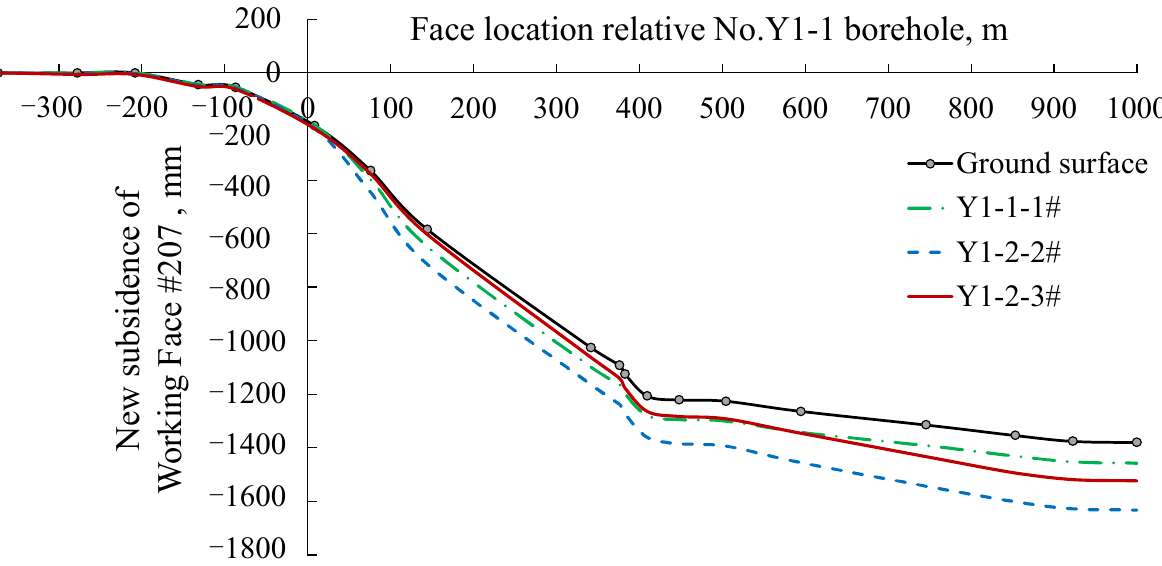
Figure 15. New subsidence caused by the mining of Working Face #207. By performing a borehole-based in situ survey of strata fractures, comparing the distribution of cracks in the UTHS before and after the mining of Working Face #207, and monitoring both the internal strata movement and surface displacements of this region, we determined that the Luohe Formation UTHS was not poised in a suspended and unmoving state during the mining of Working Face #207. Therefore, it was unlikely that a large and sudden break would occur in the UTHS during the mining of Working Face #207.